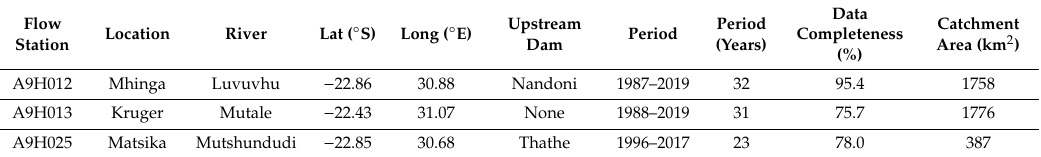
Table 1. Description of stream flow stations used in the study.